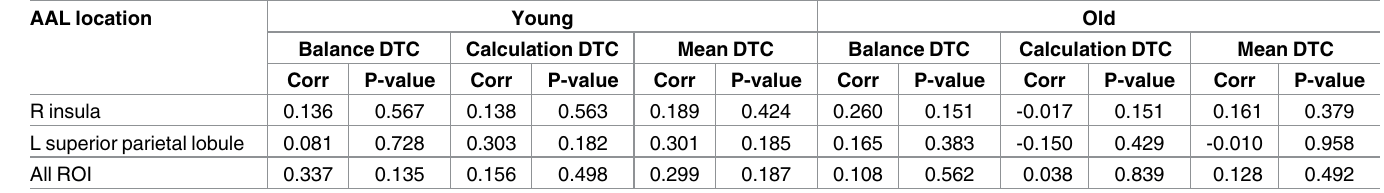
Table 5. Pearson correlation coefficients between upregulation in the right insula, left superior parietal lobule, and mean upregulation across all ROI’s, and balance, calculation, and mean dual-task costs (DTC). There were no